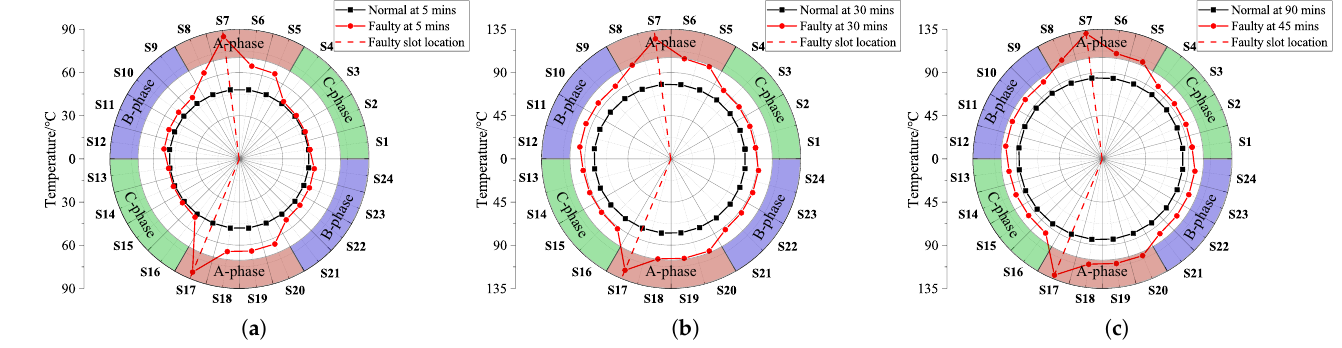
Figure 12. Temperature distribution of motor windings at different moments. ( a ) Five minutes. ( b ) Thirty minutes. ( c ) Final moment. In order to measure the temperature distribution of stator winding before and after fault, variance ( S 2 ) is used to evaluate the dispersion of winding temperature distribution caused by the fault. S 2 in Table 6 is the temperature variance of all 24 slots. Under normal 1 conditions, the S 2 value is small, indicating that normal motor-winding temperature is 1 evenly distributed, while the dispersion degree of overall winding temperature is